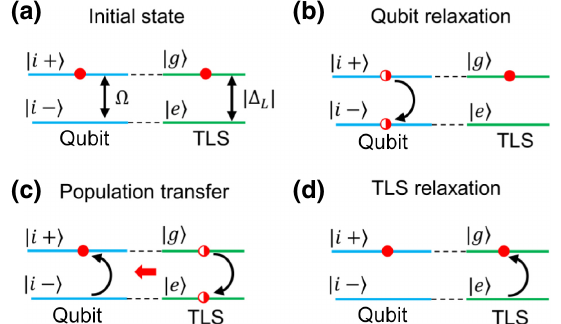
FIG. 6. Population transfer mechanism in the case of a “hot” TLS defect ( (cid:11) L < 0). Energy level diagrams in the rotating frame are shown at different stages of the population transfer pro- cess. (a) Qubit and defect are initialized to states | i +(cid:7) and | g (cid:7) , respectively. (b) Qubit population is distributed between state | i +(cid:7) and state | i −(cid:7) due to the qubit relaxation process. (c) Pop- ulation is transferred from the TLS defect to the qubit. (d) TLS defect is reset to state | g (cid:7) by the defect energy relaxation